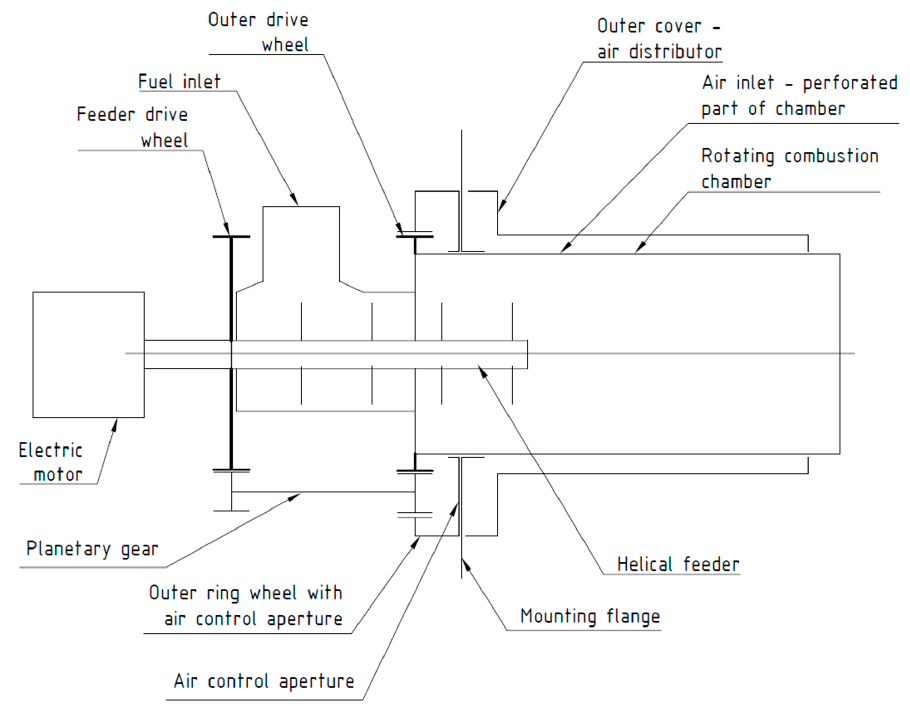
Figure 2. Schematic diagram of novel rotary burner.